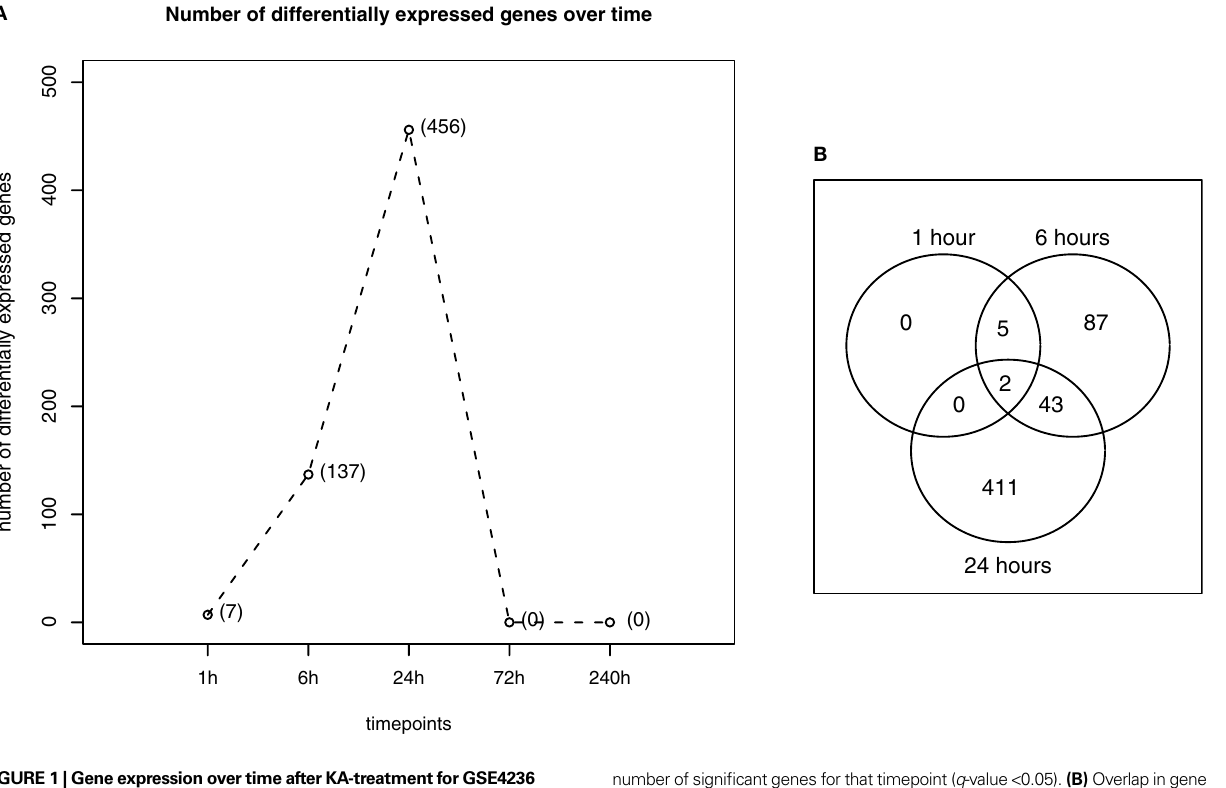
number of signifi cant genes for that timepoint ( q -value < 0.05). (B) Overlap in gene expression between different timepoints. A gene is signifi cant for two timepoints if q -value < 0.05 for both timepoints and the direction of change is the